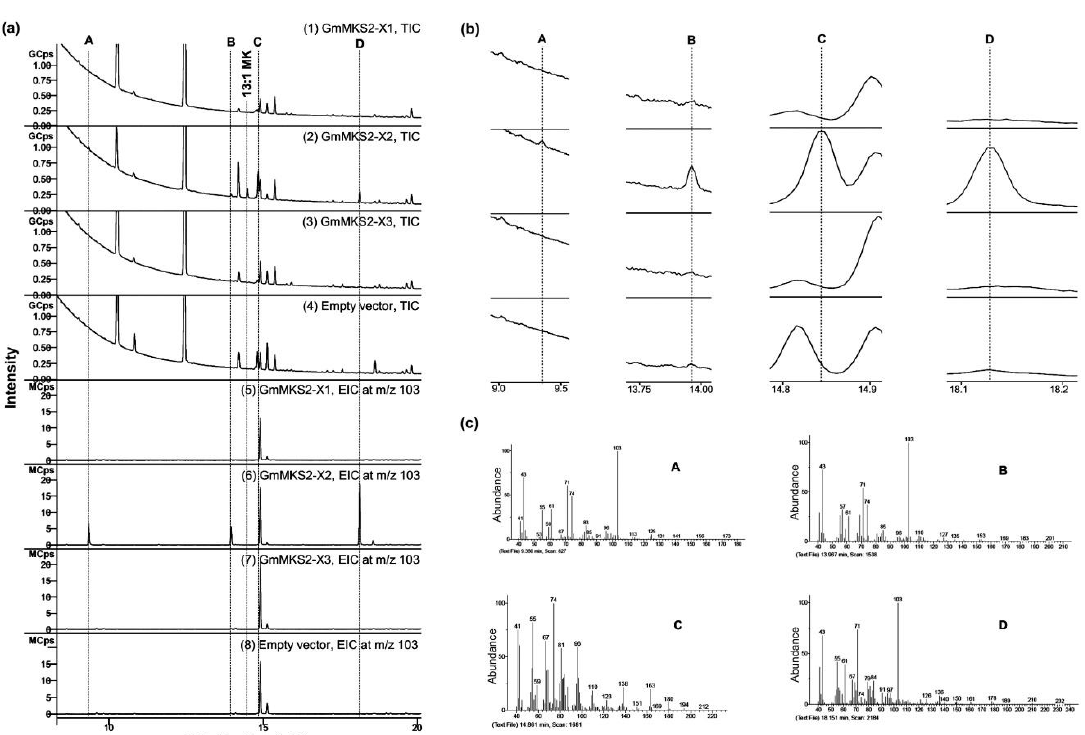
Table 1. Quantification of 2-methylketones detected following heating of the culture media of E. coli cells expressing the main isoform of GmMKS2 (GmMKS2-X2). Cells were grown, and media were collected and treated as described in “Materials and Methods.” The products 2-methylketones, which were derived from 3-ketoacids, were quantified by comparison of the peak areas with those of a linalool internal standard using GC. Values are averages ± SE calculated from three replicates (R1, R2, and R3). Significant differences were assessed by one-way ANOVA followed by Tukey’s HSD (honest